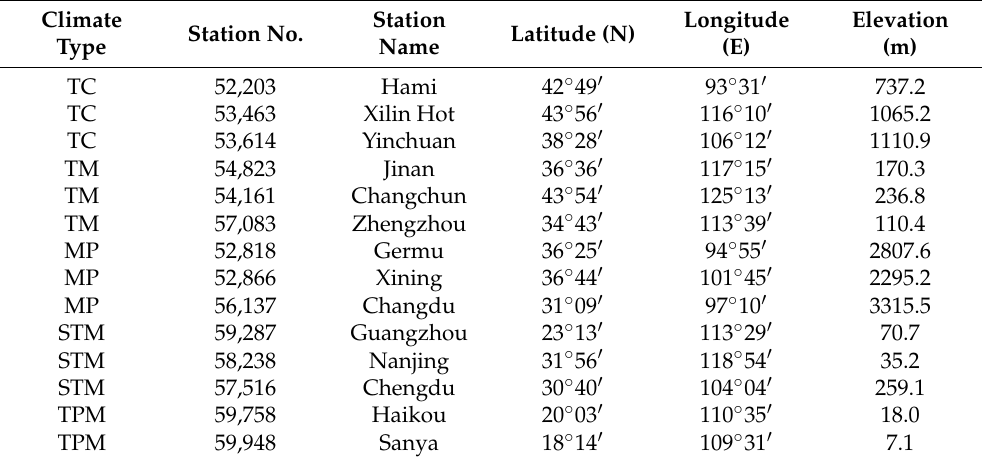
Table 1. Geographic characteristics of the 14 national meteorological stations located in different climate